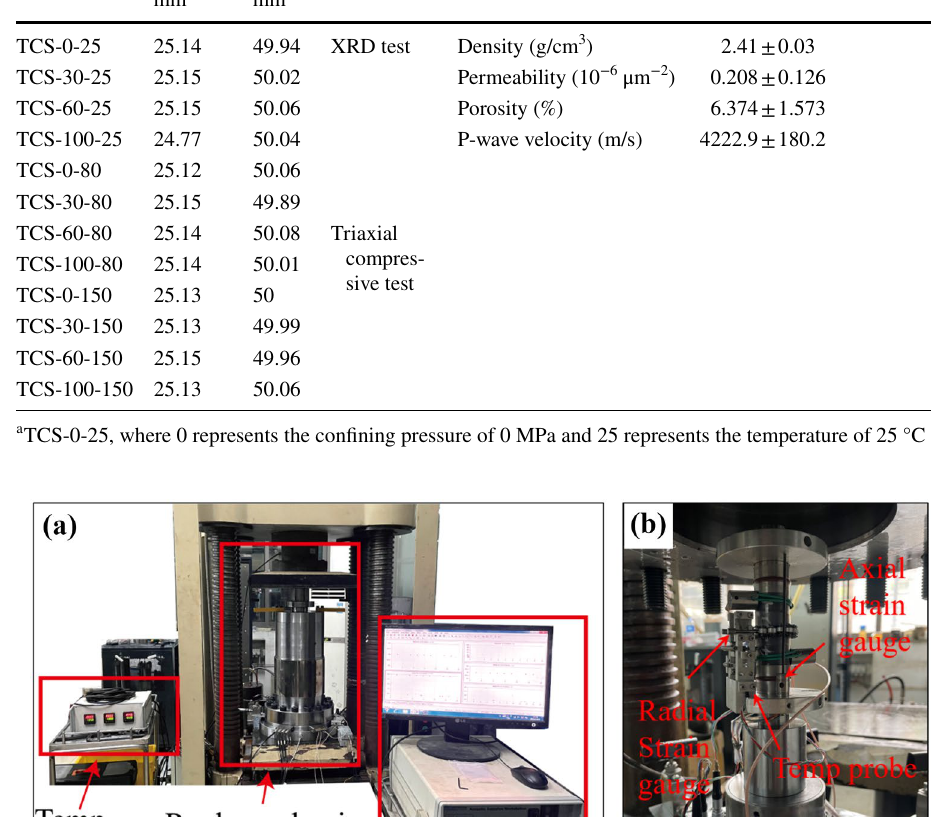
and fundamental physical properties